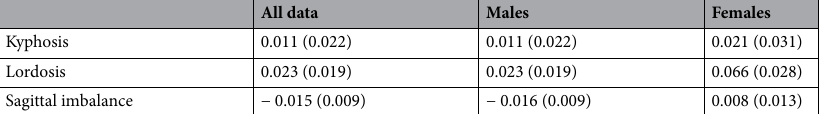
Table 4. The fixed coefficients (with standard error in brackets) of the models for a main thoracolumbar/ lumbar coronal asymmetry